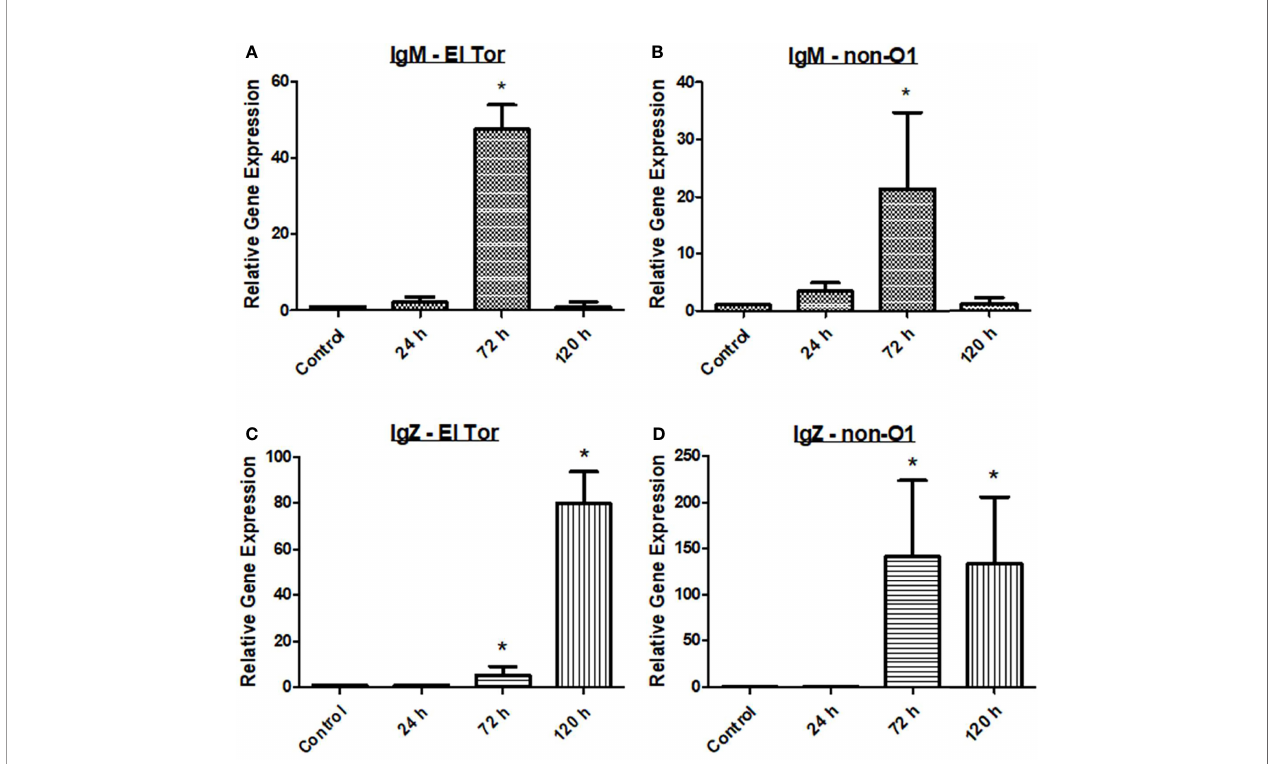
FIGURE 3 | IgM and IgZ levels increase during V. cholerae infection. WT zebra fi sh (n=5) were infected with E7946 (El Tor) or 25493 (non-O1) strains of V. cholerae at 2.5 x 10 7 CFU/mL and then sacri fi ced at the indicated time points. (A) IgM expression in fi sh infected with El Tor strain E7946. (B) IgM expression in fi sh infected with non-O1 strain 25493. (C) IgZ expression in fi sh infected with El Tor strain E7946. (D) IgZ expression in fi sh infected with non-O1 strain 25493. mRNA levels were determined through qRT-PCR. Gene expression was normalized against b -actin and expressed as fold change. Error bars indicate standard deviation. Data shown is from three experiments. *P < 0.05 as compared to